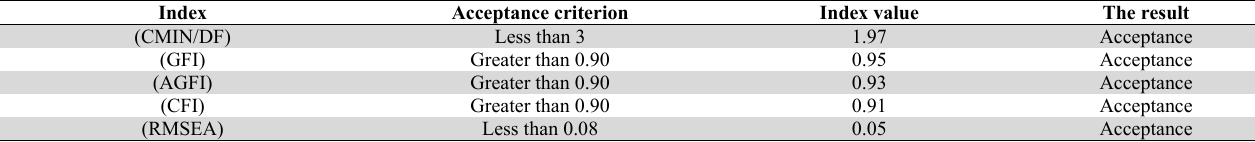
Indicators of quality matching the model to the study data